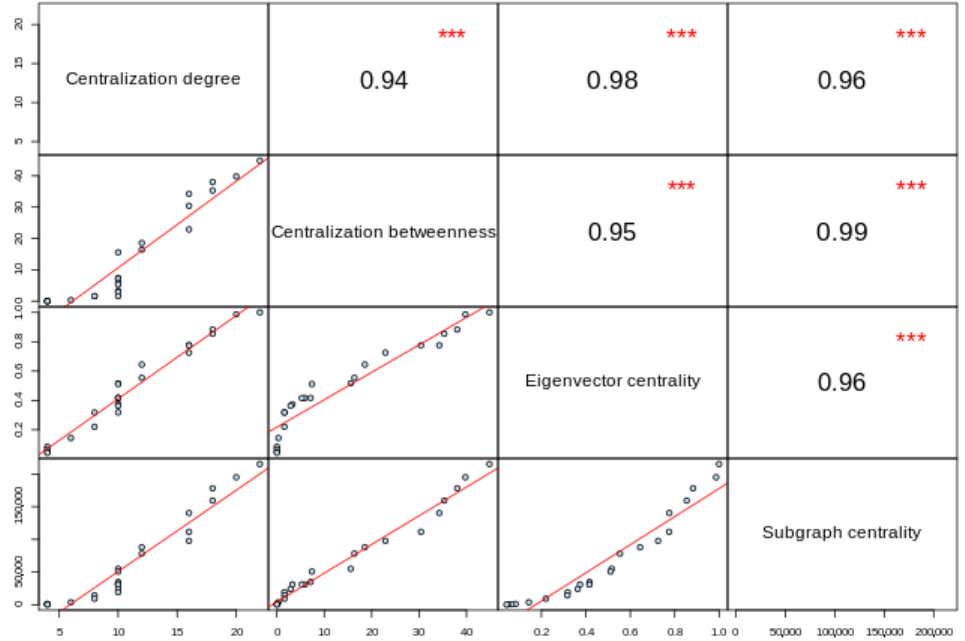
Figure 6. Matrix-like plot showing pairwise correlations of the centrality scores. The upper-right part shows the numerical correlation between the given topological features, whereas the lower-right part of the matrix is the scatterplot of one feature against another. These high correlations between centrality metrics provide useful insights into the potential of different nodes within a network [147] ; particularly, the presence of highly connected nodes is likely to be rated as central by other metrics, representing a putative core that for the aims of this study might result in potential biomarkers. Figures were obtained from the Network Analysis Profiler v2.0 [61]. *** Statistically significant correlation ( p < 0.001).